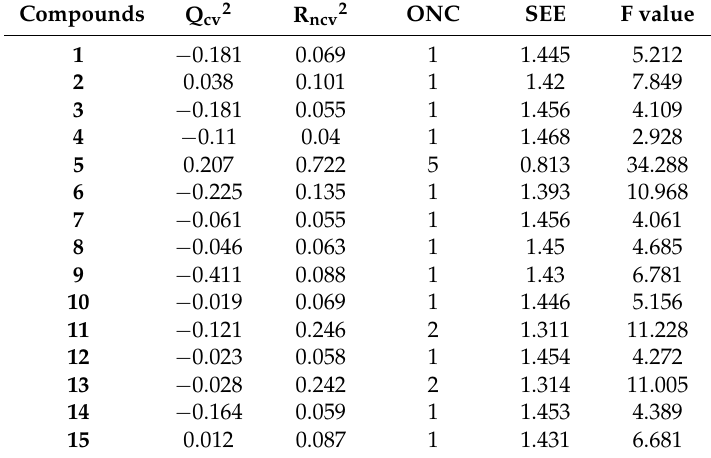
Table 3. Statistical parameters of the CoMFA models derived from Y-randomization tests. Compounds Q cv2 R ncv2 ONC SEE F